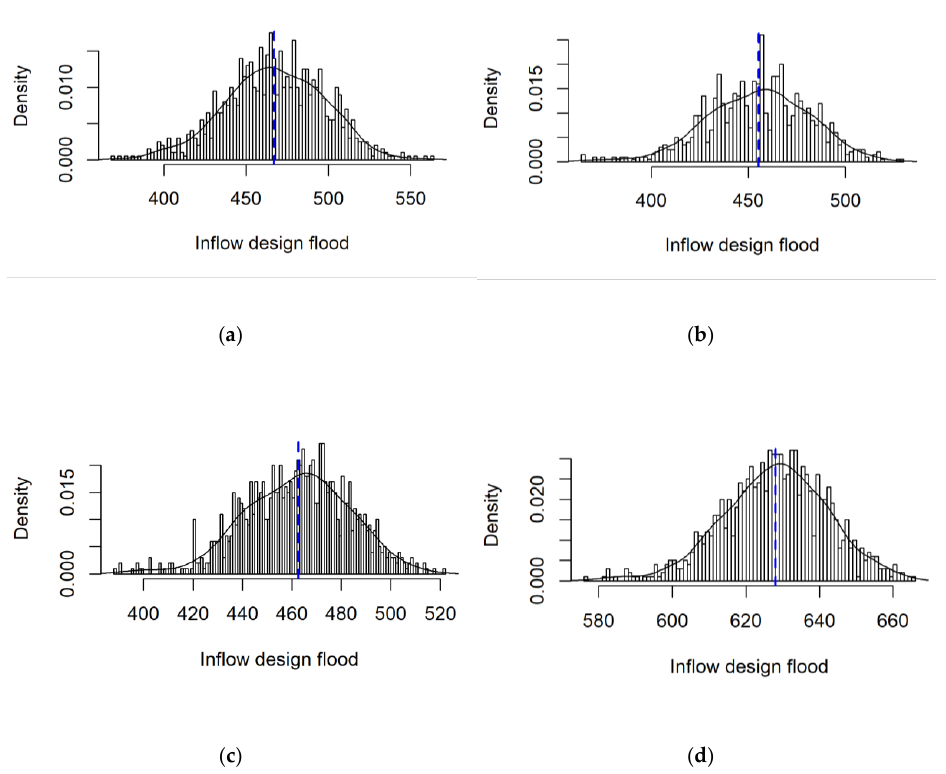
Figure 10. Bootstrap histogram of the inflow design flood for a 24-h duration and a 200-y return period during 2011–2040 under the RCP4.5 scenario for four agricultural reservoirs. The blue dashed line the denotes original of θ̂ . The estimator ( θ̂ ) is the mean. ( a ) H-ON reservoir; ( b ) G-BO reservoir; ( c ) G-DB reservoir; ( d ) Y-DY reservoir. Refer to Table 1 for reservoir names.